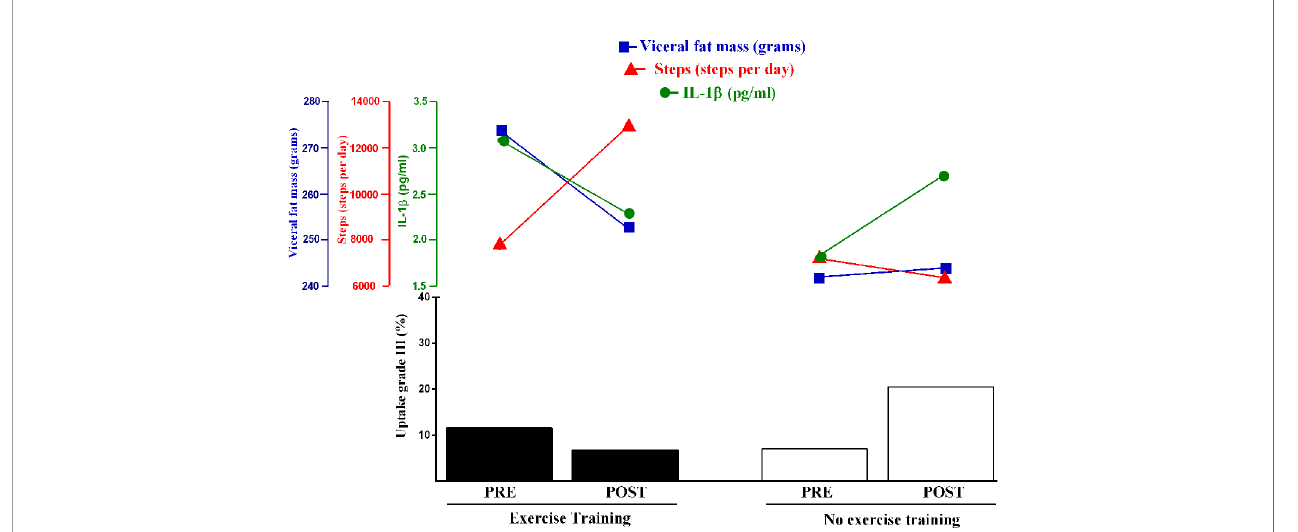
FIGURE 4 | Overview of the changes in severe arterial in fl ammation, visceral fat mass, IL1- b , and number of steps following a 12-week, home-based, exercise training program or control (no exercise) in c-TA patients. Noticeably, the exercise-induced amelioration in severe arterial in fl ammation was mirrored by decreases in visceral fat and IL-1 b levels (tendency towards signi fi cance) and increases in physical activity. The hypothesis raised by this study that these responses might be interrelated should be tested by larger